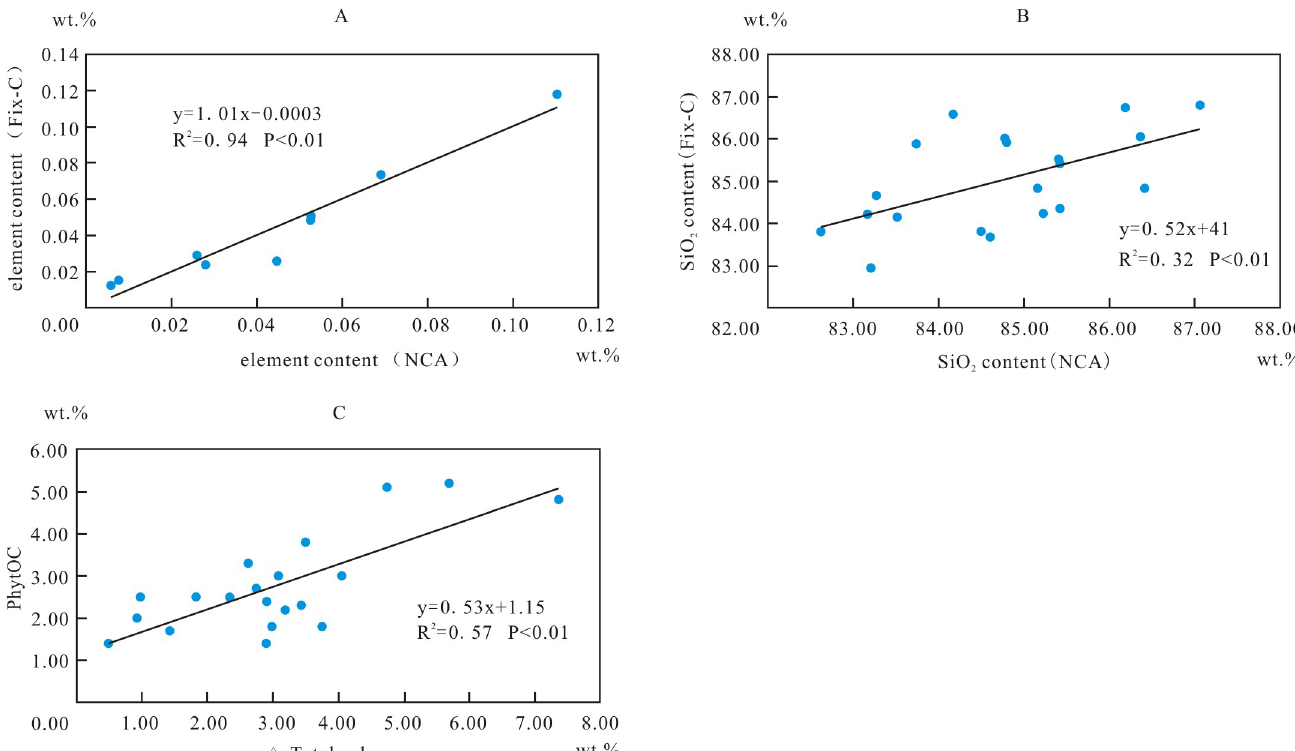
Fig 5. EPMA results of phytolith are comparative when using non-carbon analysis and the Fix-C model. A, a positive correlation exists between the contents of 9 elements determined in phytolith particles from D . ronganensis leaves; B, the SiO 2 content of phytoliths determined using NCA and Fix-C model correlated positively; C, 4 Total values (the difference between the total values from NCA and Fix-C model) correlated with fixed C values (PhytOC).